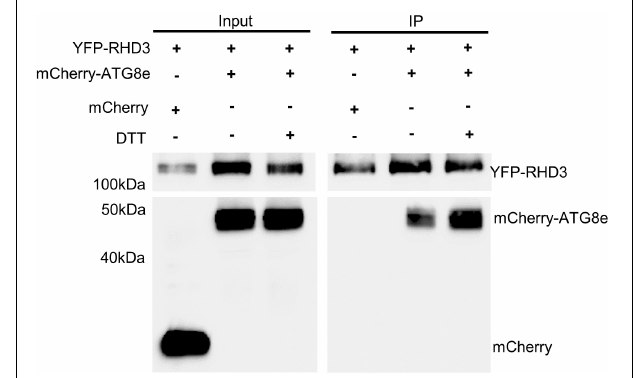
FIGURE 6 | Co-immunoprecipitation (Co-IP) assay of the interaction between RHD3 and ATG8e. mCherrry-ATG8e (lane 2), but not mCherry (lane 1), was copurified by YFP-RHD3. Notably, the increased amount of mCherry-ATG83e was copurified by YFP-RHD3 in the presence of 10 mM DTT (in comparison of lane 3 with lane